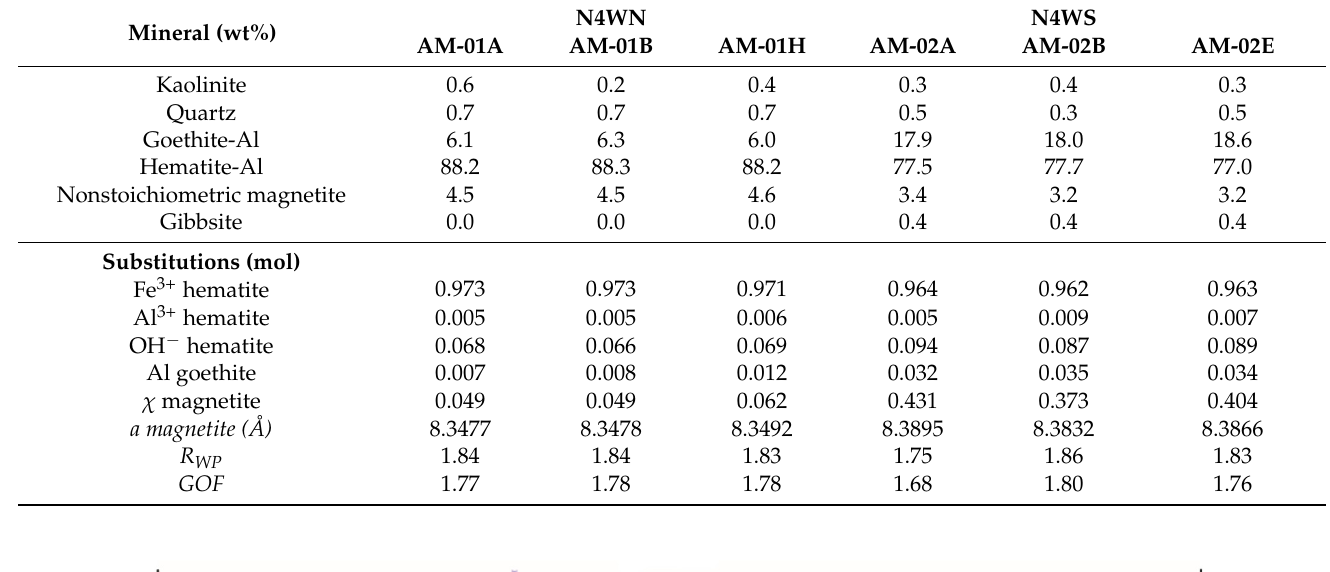
Figure 3. Guaíra soil particle observed by reflected light microscopy, and Raman spectra with diagnostic vibrations of (1) hematite (225, 293, 415, 500, 618 cm − 1 ); (2) ilmenite (225, 390, 670 cm − 1 ); (3,4) nonstoichiometric magnetite (675 cm − 1 ); (5) maghemite (667, 720 cm − 1 ); (6) maghemite and goethite intergrowth (243, 293, 385, 399, 470, 547 cm − 1 ).